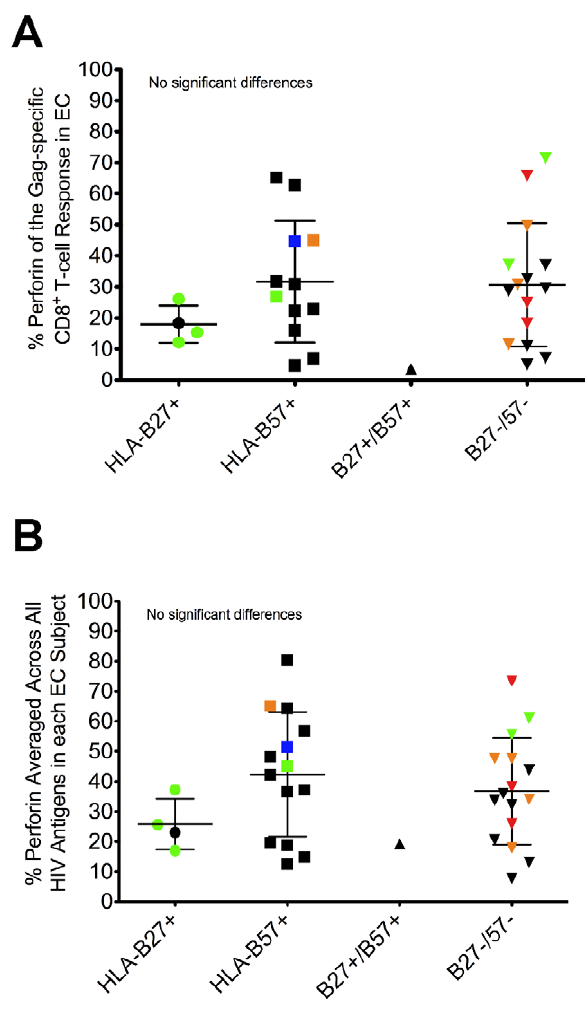
Figure 3. Perforin expression is not restricted to the presence of protective HLA-B alleles. EC were stratified based on the expression of HLA-B alleles previously shown to be associated with improved clinical outcomes. The relative amount of perforin expression is shown for the (A) Gag-specific and (B) average HIV-specific CD8 + T- cell responses among all EC. Each symbol represents an individual study subject. Some of the symbols are colored to denote the presence of another protective HLA-B allele: blue, HLA-B13; green, HLA-B15; orange, HLA-B51; red, HLA-B58. No statistically significant differences were found between the groups using a one-way ANOVA test (nonparamet- ric; Kruskal-Wallis) followed by a Dunns test for multiple comparisons. The error bars represent the mean and standard